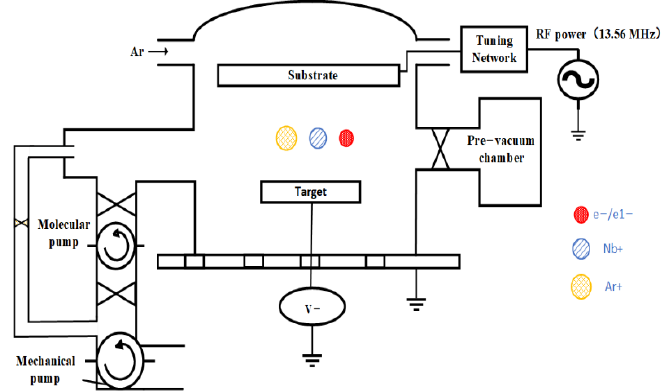
Figure 1. Processing chamber scheme.